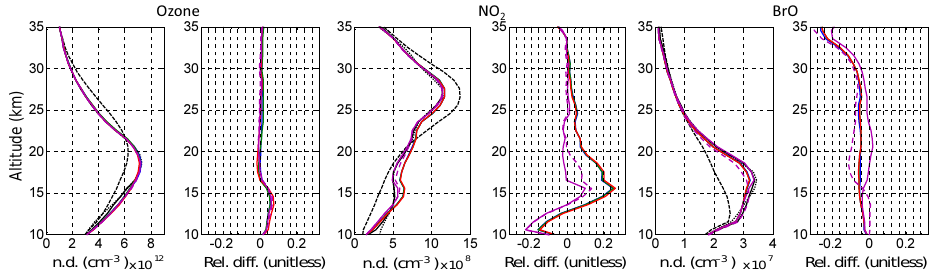
Figure 15. Same as upper panel of Fig. 13 but for an extended UV fit window (332–357nm) including an additional BrO absorption band at shorter wavelengths.